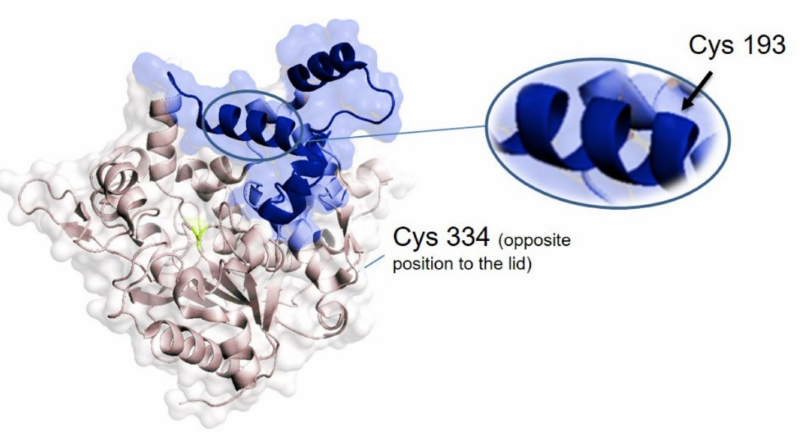
Figure 3. Three-dimensional structure of the G. thermocatenulatus lipase (GTL) marking the position of the different variants. The protein structure was obtained from the Protein Data Bank (pdb code: 2W22) and the picture was created using Pymol v.